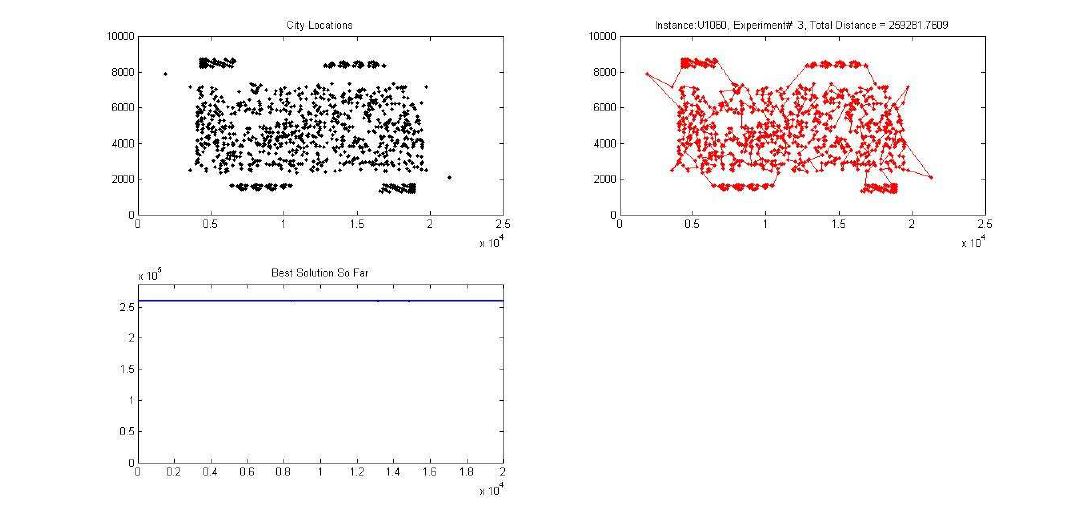
Figure 4. Graph illustrating one of the experiments on the U1060 instance of TSP (containing 1060 cities) solved by the proposed BCSO algorithm. The graph depicts the city location, total distance and best solution found.